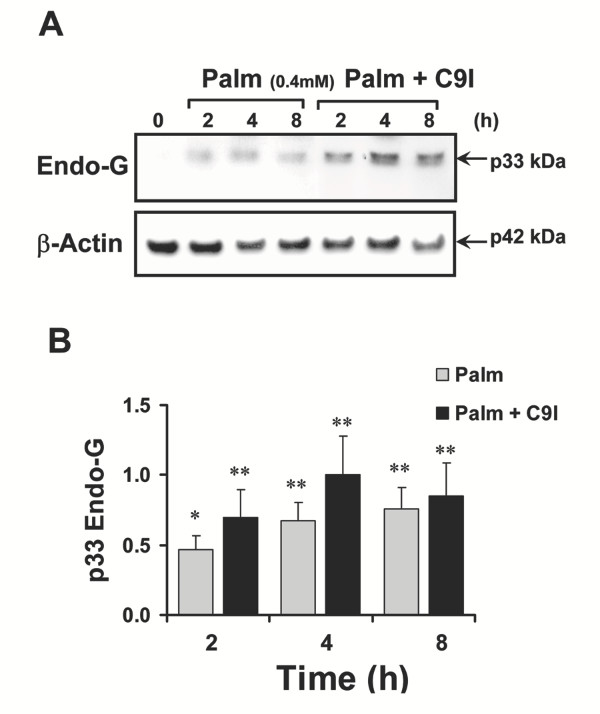
Palmitate stimulates translocation of the proapoptotic endonuclease G protein by a caspase 9-independent mechanism. (A) HMC were incubated with palmitate (Palm) and palmitate plus the Z-LEHD-FMK caspase 9 inhibitor (C9I, 40 μM) for the times indicated. The cells were fractionated and the level of p33 endonuclease G protein was measured by Western blotting in the cytoplasmic fraction. Equivalent amounts of protein were added to each lane, as confirmed by reprobing with β-actin. (B) Densitometry of cytoplasmic p33 kDa endonuclease G protein from 3 independent experiments. **, P < 0.01, *, P < 0.05 by ANOVA versus 0 time.